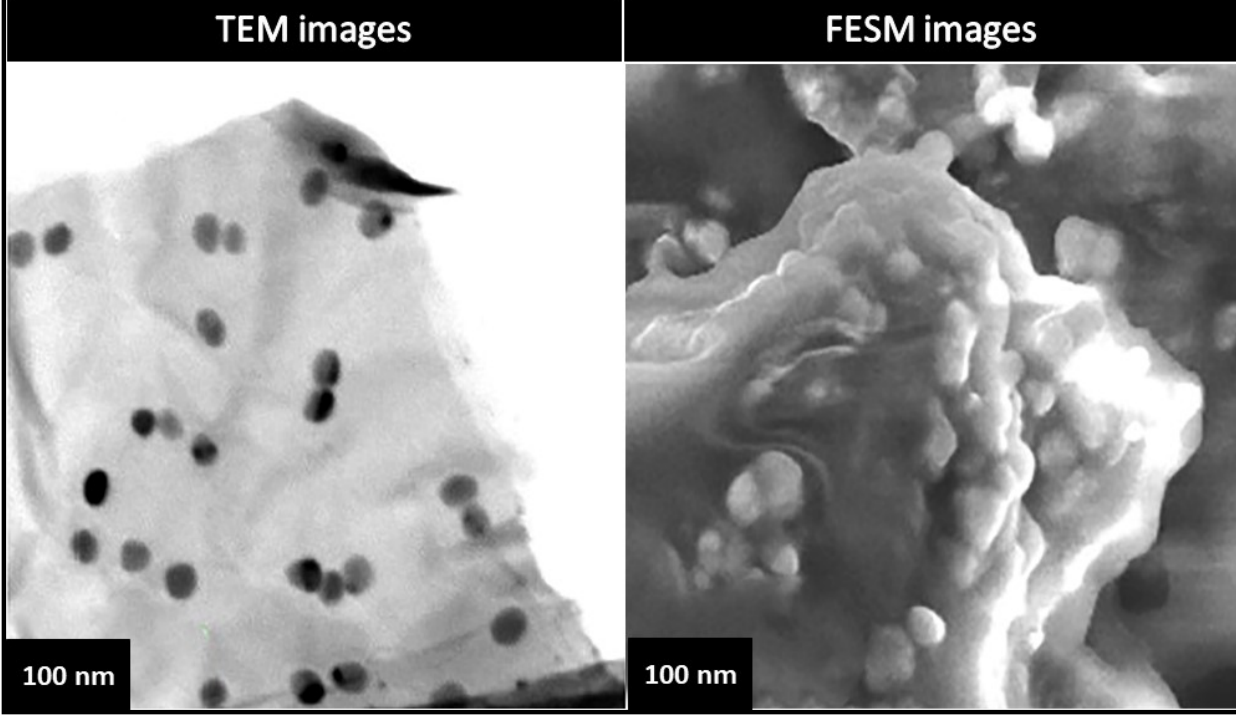
Figure 15. The TEM and FESM images of nanoparticles Graphene oxide-silicon dioxide (GO-SiO 2 ). Reprinted with permission from ref. [47]. © 2016 Elsevier B.V.